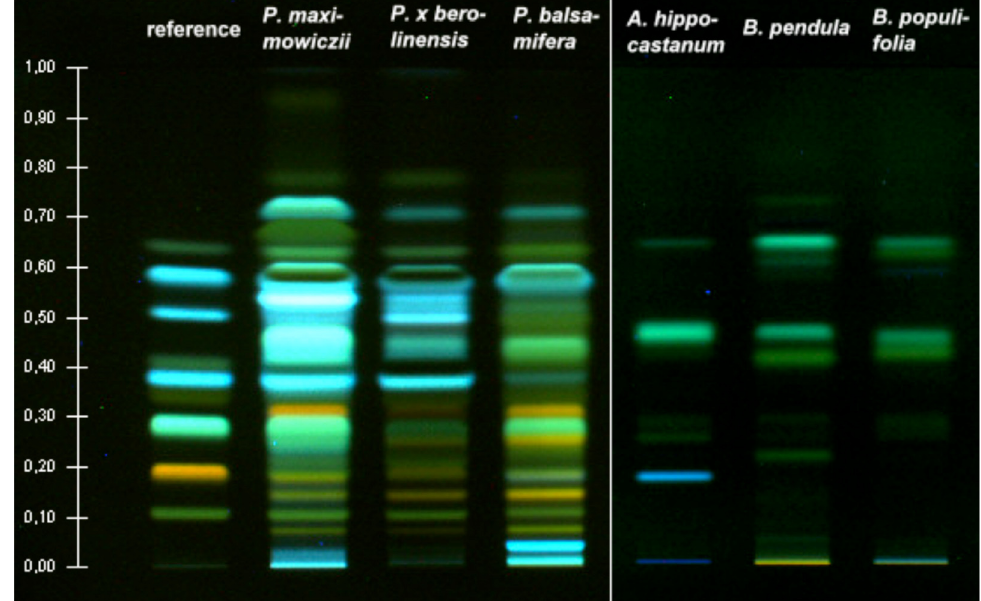
Fig. 4: TLC fingerprints of bud extracts from Populus maximowiczii A. Henry , P. x berolinensis (K. Koch) Dippel, P. balsamifera L . , Aesculus hippo- castanum L., Betula pendula Roth and B. populifolia Marsh. (each 10 μL). The applied volume for the reference was 25